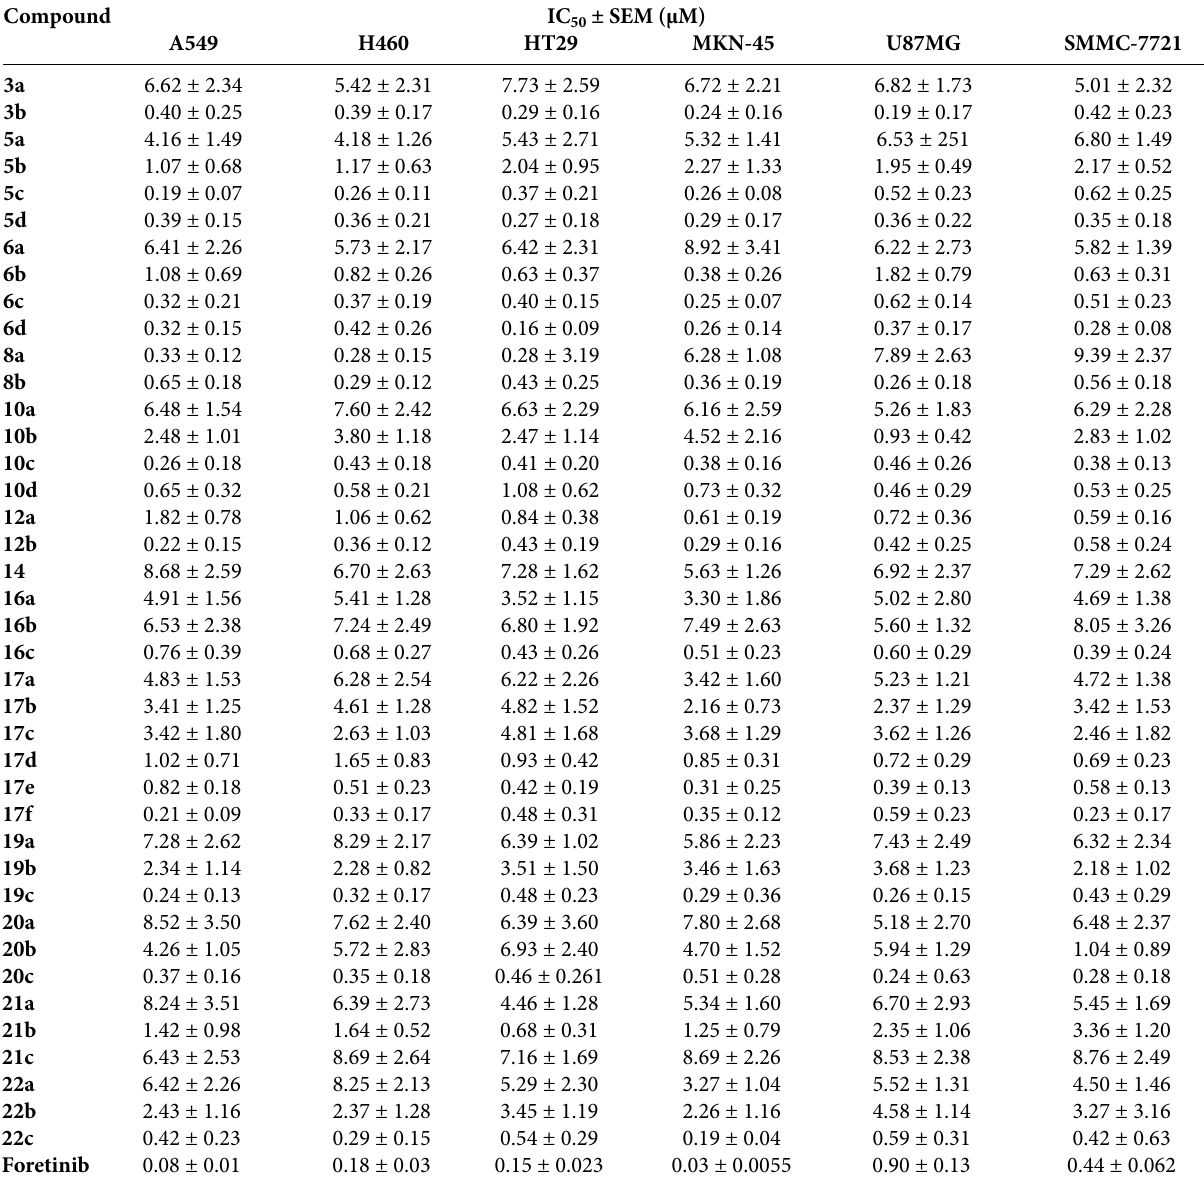
Table 1. In vitro growth inhibitory effects IC 50 ± SEM (µM) of the newly synthesized compounds against cancer cell lines